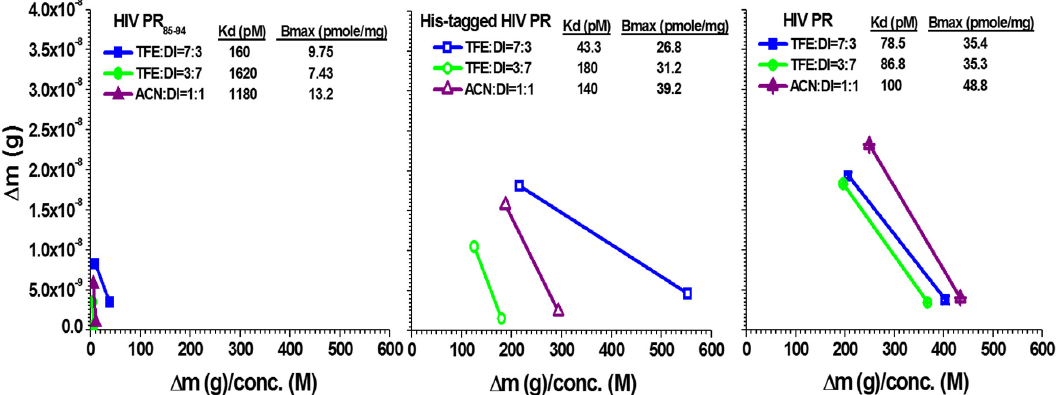
Figure 3. Adsorption e ff ects of the HIV PR-HEMIPs chip. The dissociation constants and the maximum frequency shift were observed [30,31]. Each graph was observed using three selective solvents for three kinds of analytes, including template solutions: HIV PR 85–94 , His-tagged HIV PR, and HIV PR. The injected concentration of the analytes were 0.01, 0.1, and 1 ng / mL, respectively. ∆ m, the mass di ff erence on the quartz surface. PR, protease; HEMIPs, helical epitope-mediated molecularly imprinted polymers. TFE, 2,2,2-trifluorethanol; DI, deionized water; ACN,